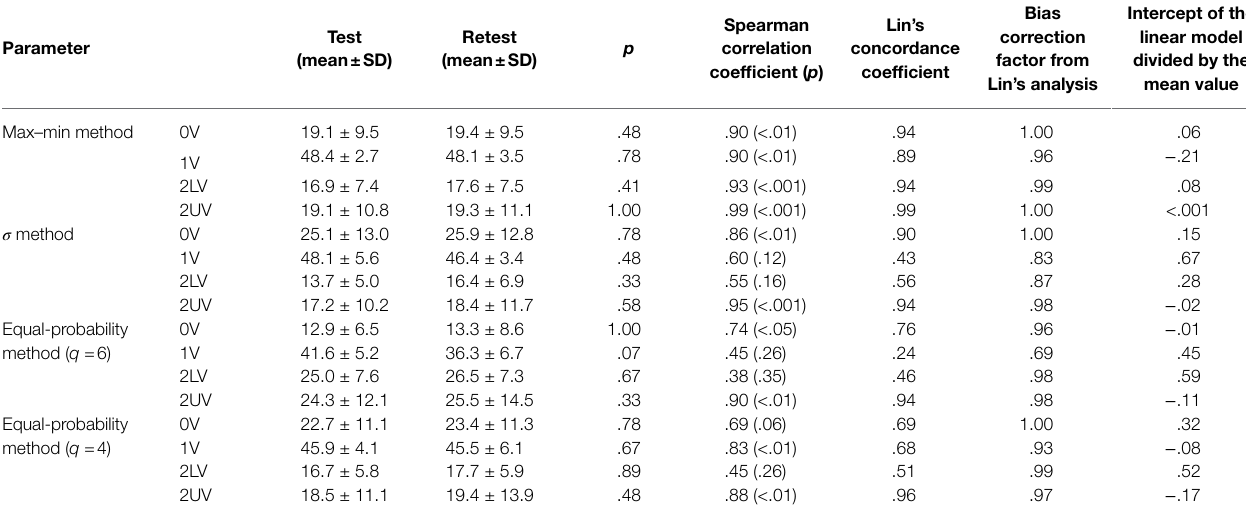
TABLE 2 | Results of the comparison between Test and Retest in analyzed symbolic dynamics indices.